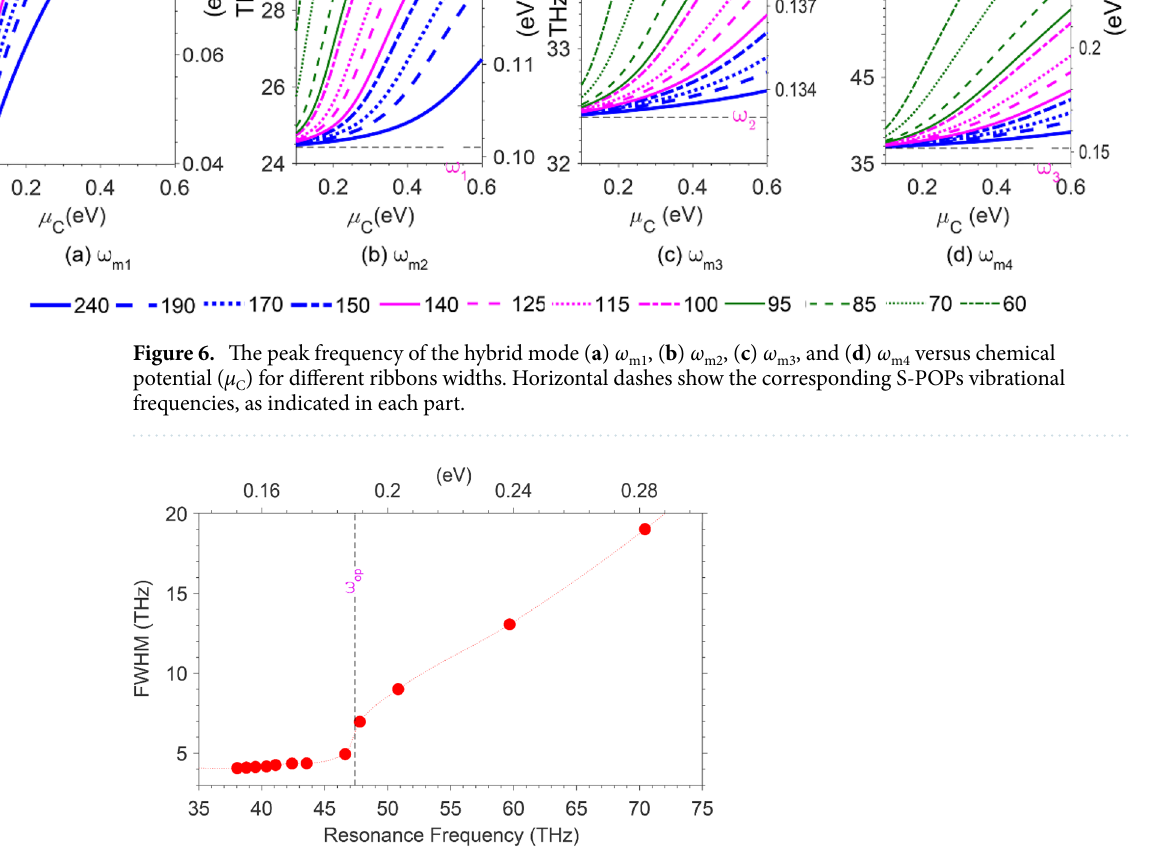
Figure 7. FWHM for m 4 as a function of the corresponding plasmon resonance frequency extracted from Fig. 5a. The dashes show the locus of ω op